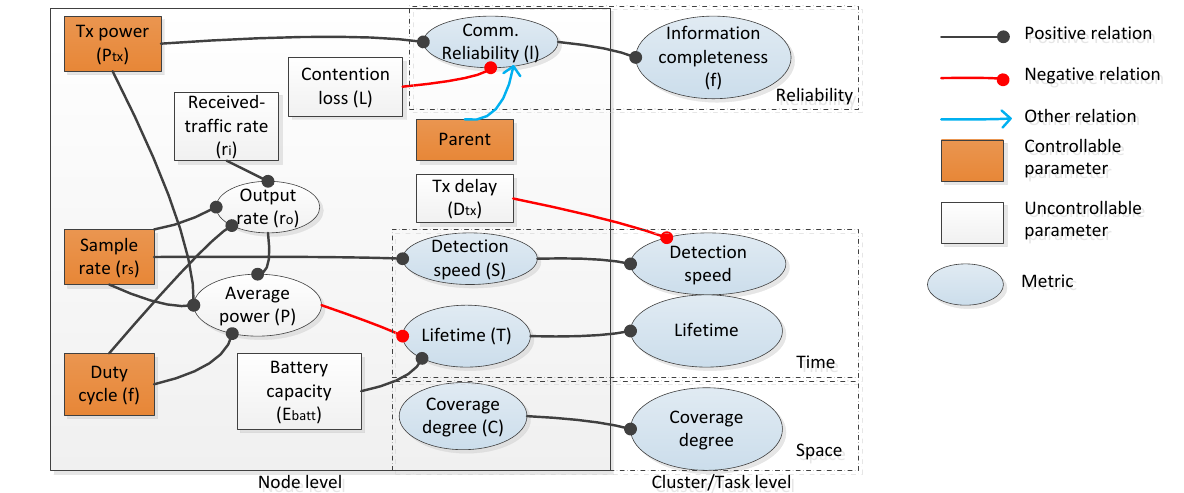
Figure 13. The basic mapping model .